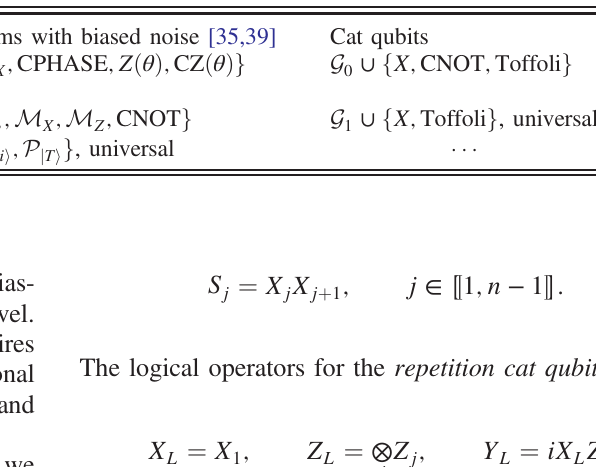
TABLE I. Construction of a universal set of fault-tolerant gates that exploit the noise bias of the physical qubits. The middle column represents the case of regular two-level systems [35,39], and the right column represents the case of cat qubits. For regular qubits, only a few fundamental bias-preserving operations are allowed, leading to a limited set of C 1 -logical operations. To achieve universality, it is necessary to concatenate with a second level of encoding C 2 , at which magic state preparation and distillation are appended. On the other hand, the set of fundamental biased-preserving operations for cat qubits contains extra gates. This extended set enables us to build a universal set of fault-tolerant gates already at the repetition code level and without requiring magic state preparations and distillations. Furthermore, the circuits for the realization of protected logical gates are significantly simpler than regular two-level systems.